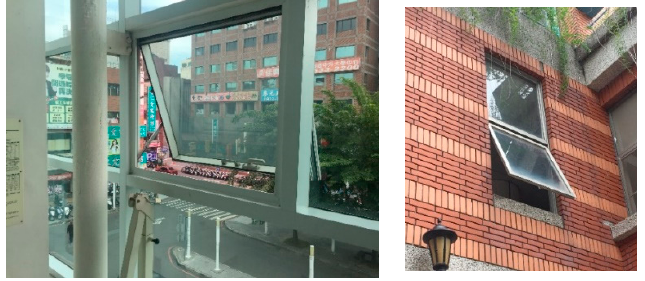
Figure 2. Awning window examples.